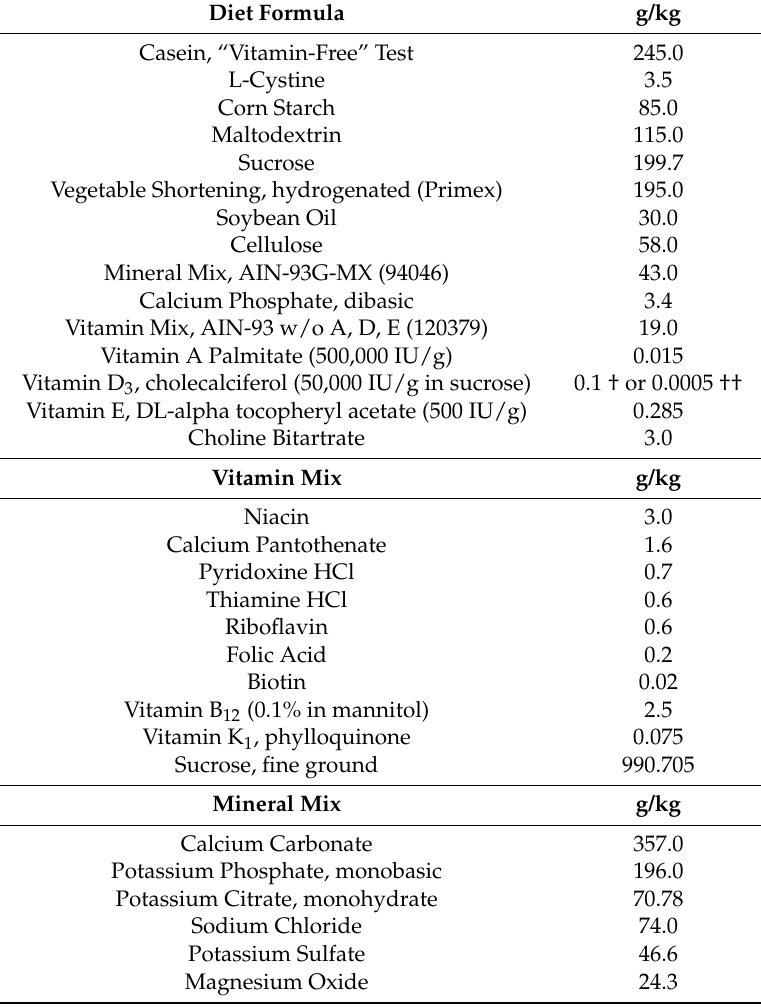
Table A1. Composition and macronutrient distribution of the high fat and sucrose diet containing low or high vitamin